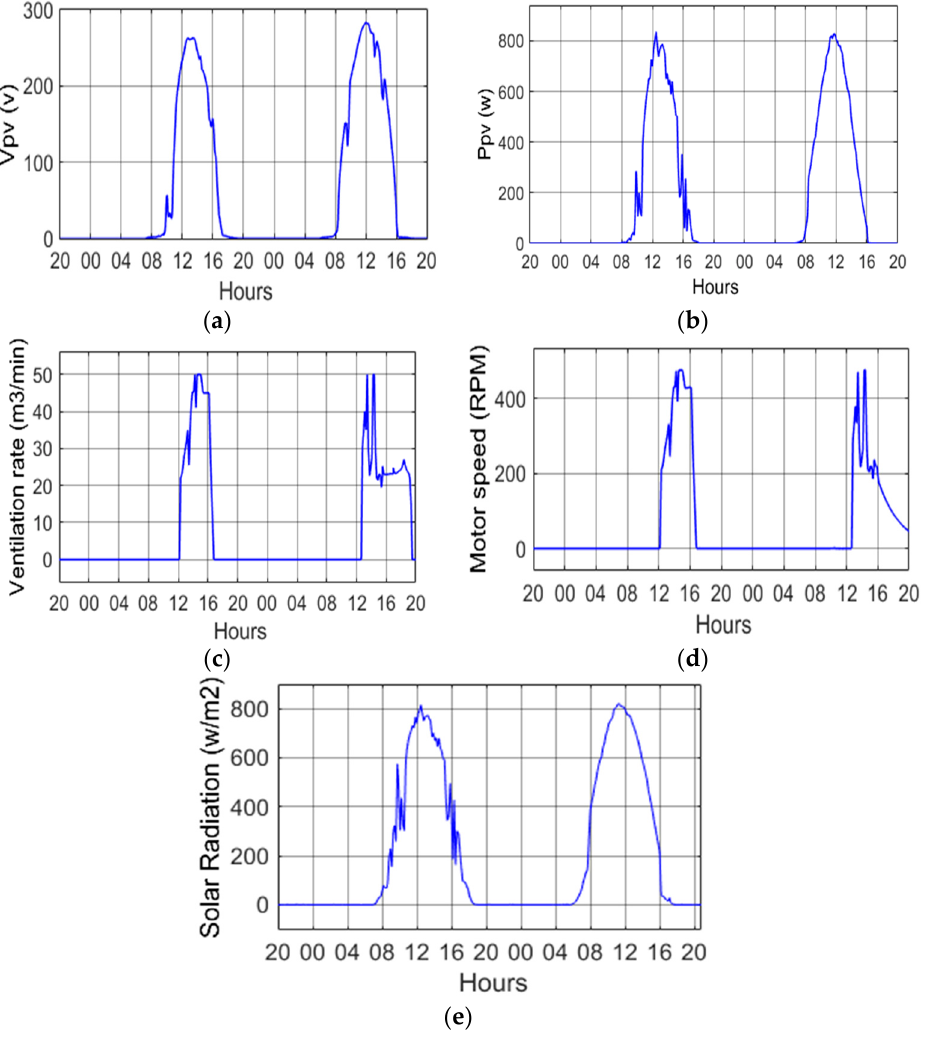
Figure 25. Simulation of the ventilation system powered by the PV system. ( a ) Voltage; ( b ) power; ( c ) ventilation rate; ( d ) motor speed; ( e ) real solar radiation.